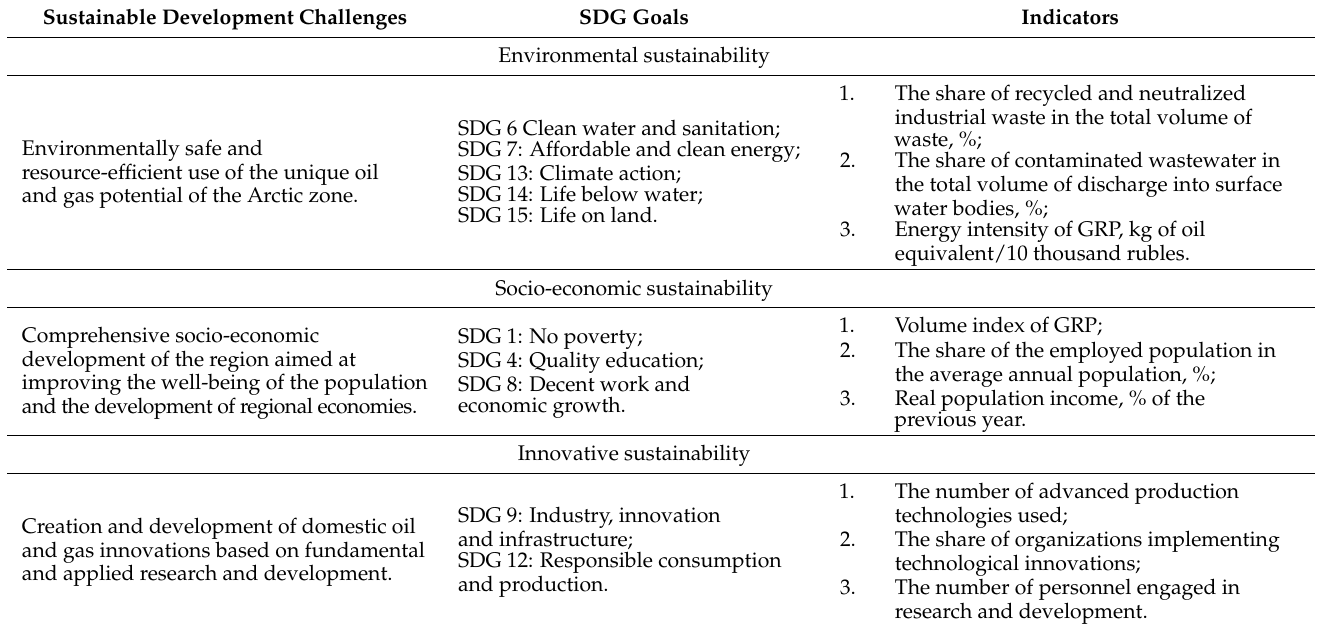
Table 2. Indicators of environmental, socio-economic, and innovative sustainability of the development of oil and gas resources in the